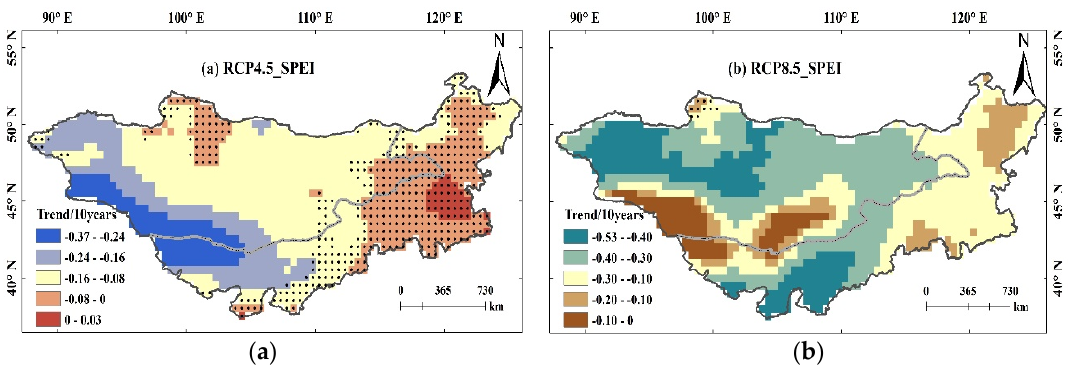
Figure 7. Changes to the spatial distribution of the annual standardized precipitation evapotranspiration index (SPEI) under the ( a ) RCP4.5 and ( b ) RCP8.5 scenarios for the Mongolian Plateau. The black dots indicate insignificance at a 95% confidence level.